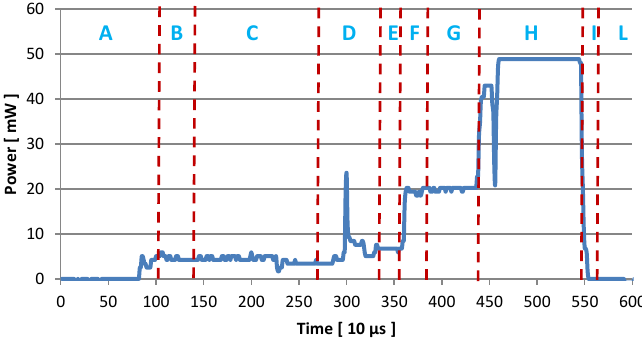
Figure 10. Voltage in the storage capacitance and transmission events with f CPU load = 50%.